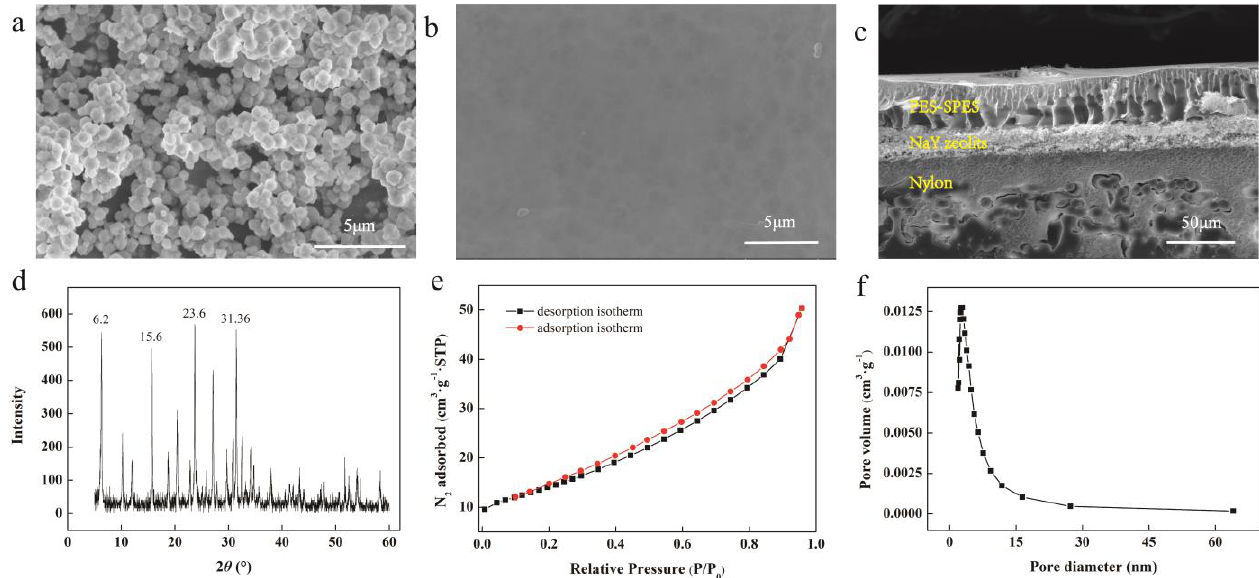
Figure 2. ( a ) SEM images of NaY zeolite; ( b ) surface SEM images of the sandwich adsorptive membranes; ( c ) cross− section SEM images of the sandwich adsorptive membranes; ( d ) XRD of NaY zeolite; ( e ) N 2 adsorption and desorption curves of the sandwich adsorptive membranes; ( f ) the curves of pore diameter distribution of the sandwich adsorptive membranes.